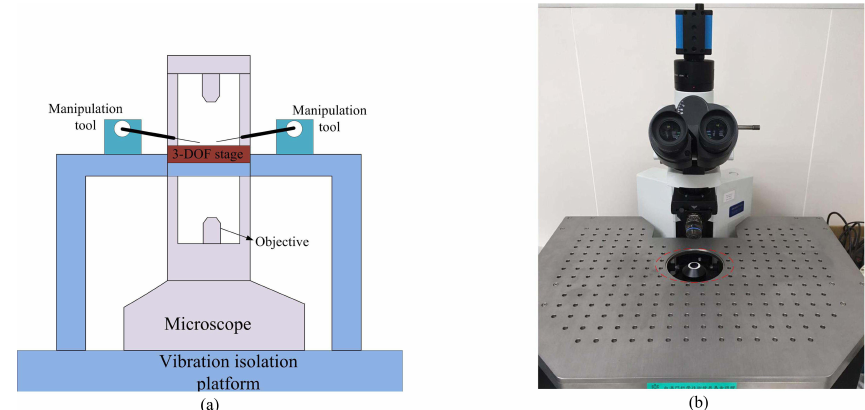
Figure 1. Micromanipulation system. (a) Schematic illustration. (b) Microscope picture.